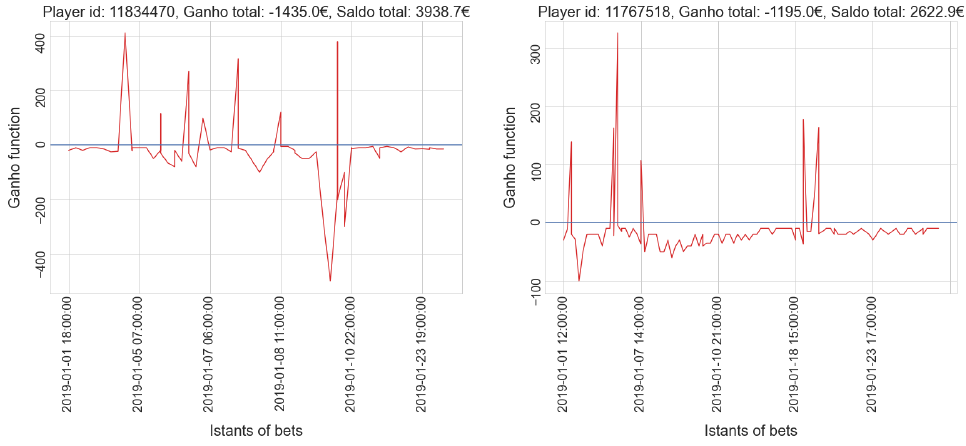
Figure 12. Time series plot of two potential medium-risk pathological